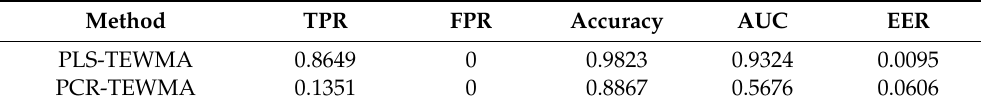
Table 6. Results of PLS- and PCR-based TEWMA charts under two modules short-circuited. Method TPR